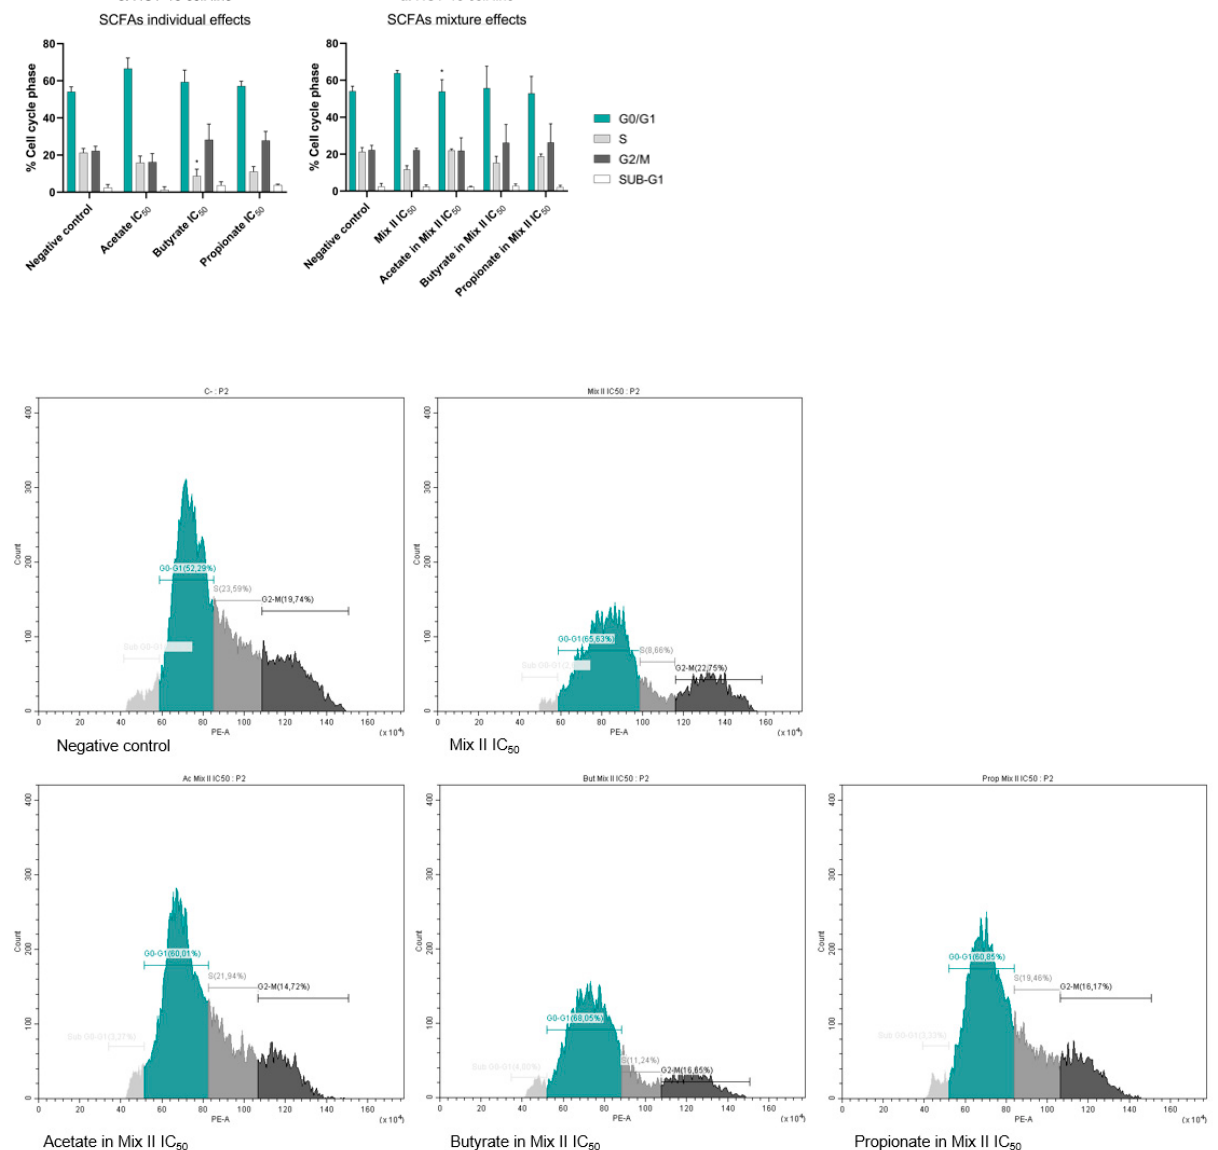
Figure 4. Cell-cycle effects induced by SCFAs, individually or in mixture, in CRC cells. Cell-cycle analysis by propidium-iodide staining by flow cytometry in RKO (A) and HCT-15 (B) cells treated with each SCFA, individually or in mixture, for 24 h. ( a ) RKO cells were incubated with the IC 50 of each SCFA (81.04 mM of acetate, 10.84 mM of butyrate, 32.25 mM of propionate). ( b ) RKO cells were incubated with the IC 50 of the mixture II, as well as the correspondent concentrations of each SCFA in that mixture (47.61 mM of Mix II containing 28.57 mM of acetate, 7.14 mM of butyrate, and 11.90 mM of propionate). ( c ) HCT-15 cells were incubated with the IC 50 of each SCFA (89.52 mM of acetate, 4.57 mM of butyrate, 22.70 mM of propionate). ( d ) HCT-15 cells were incubated with the IC 50 of the mixture II, as well as the correspondent concentrations of each SCFA in that mixture (13.67 mM of Mix II containing 8.20 mM of acetate, 2.05 mM of butyrate, and 3.42 mM of propionate). Data are from at least three independent experiments. Statistical analysis was performed using Two-Way ANOVA (p-value 0.0332 (*), 0.0021 (**), 0.0002 (***) and <0.0001 (****)). Representative histograms are represented. p > 0.001 compared with negative control cells.